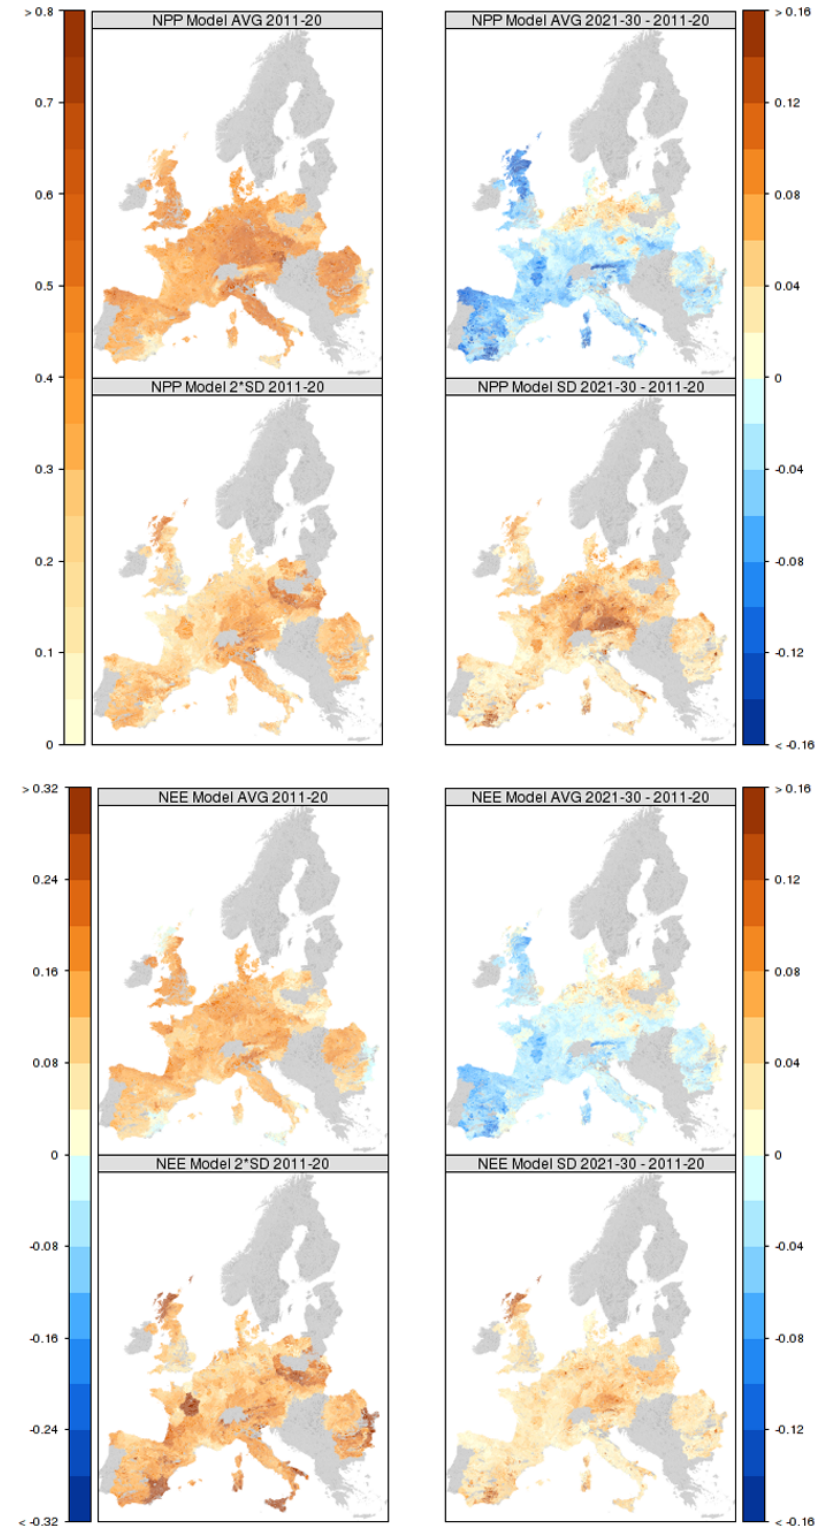
Fig. 4. NPP (top four plots) and NEE (bottom four plots) (kgCm − 2 yr − 1 ) for European beech. The first and third rows are averages over the models. The second and fourth rows are standard deviations (right column) or two times standard deviations (left column) over the models. The left column is the decadal average 2011–2020. The right column is the difference in decadal average 2021–2030 minus